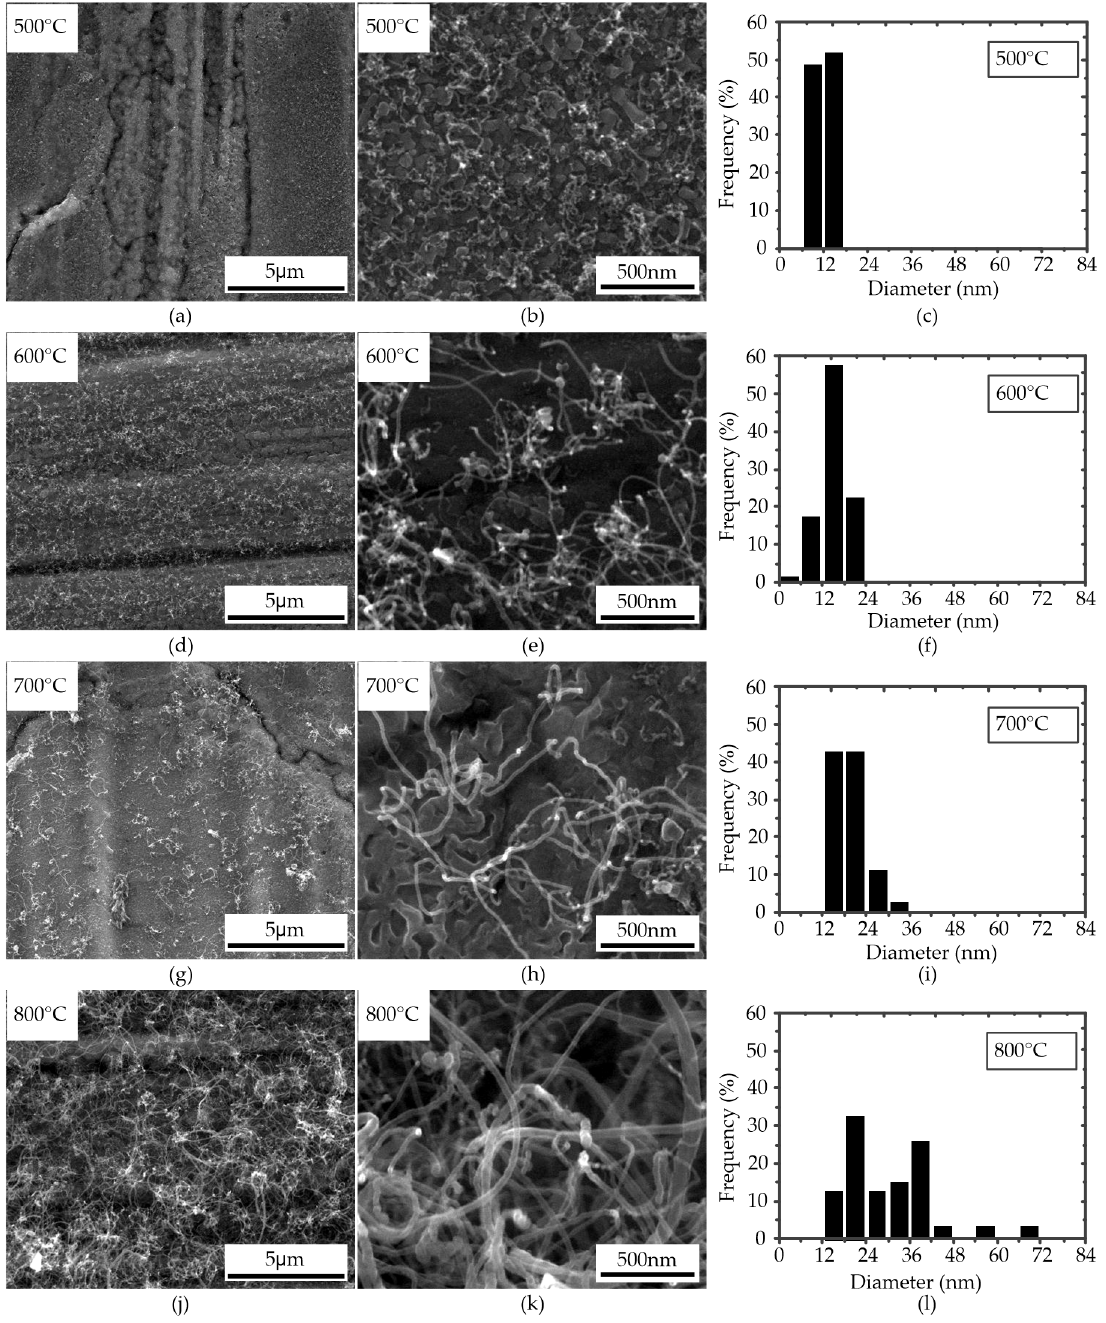
Figure 5. The SEM micrographs of the CNTs grown on the substrate with 200 sccm ethanol precursor at the temperature of 500, 600, 700, and 800 °C. (a)(d)(g)(j) : the low magnification images; (b)(e)(h)(k) : the high magnification images; (c)(f)(i)(l) : the diameter distribution of samples.